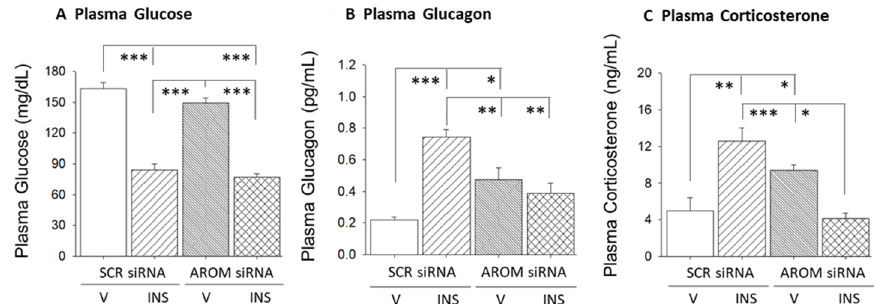
Figure 6. VMN aromatase regulation of plasma glucose and counterregulatory hormone profiles. Data illustrate effects of intra-VMN SCR or AROM siRNA administration on mean circulating glucose ( A ), glucagon ( B ), and corticosterone ( C ) concentrations ± S.E.M. for V- or INS-injected, SCR versus AROM siRNA-pretreated animals ( n = 4 per treatment group). * p < 0.05; ** p < 0.01; *** p < 0.001